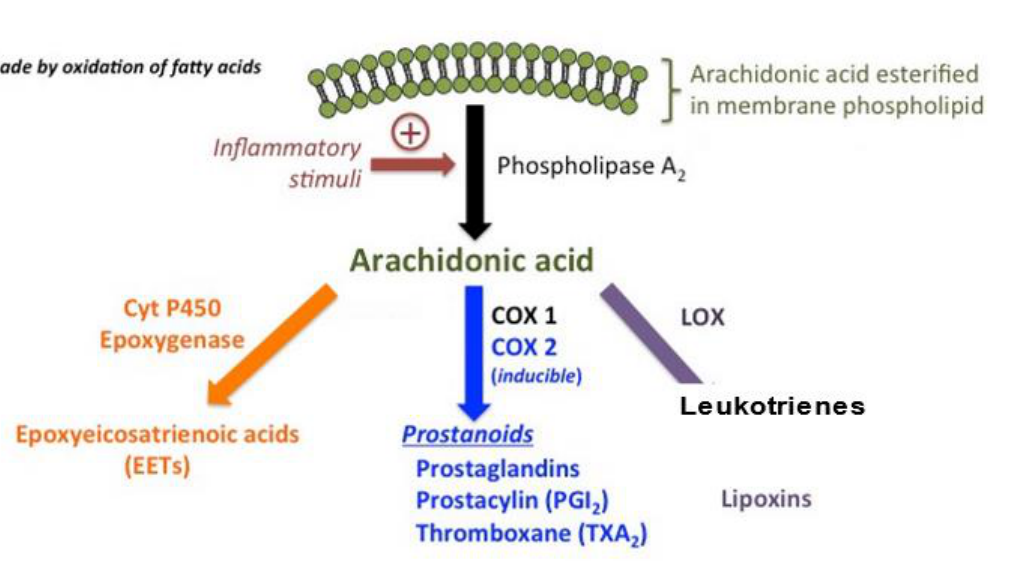
Figure 1. Arachidonic acid is the ordinary substrate for eicosanoid synthesis. The cyclooxygenase (COX) pathways form prostaglandins (PGs) and the COX pathways form leukotrienes (LTs) and the cytP450 pathways form various epoxy, hydroxy and dihydroxy